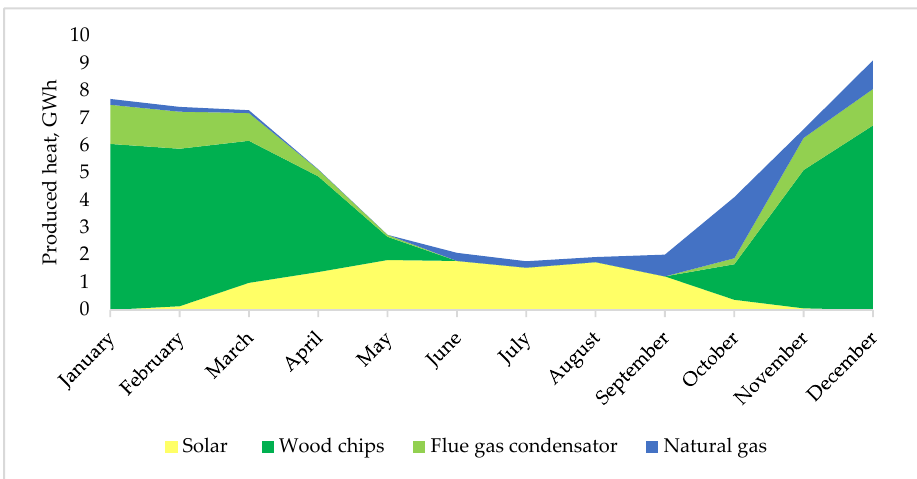
Figure 4. Produced heat by used fuel in 2020.